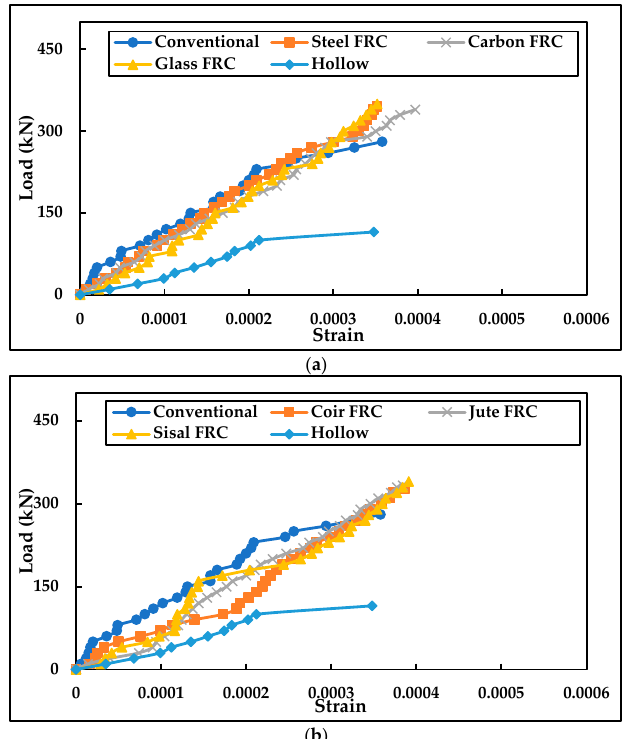
Figure 7. Graphical illustration of load vs. strain of medium columns. ( a ) Artificial FRC. ( b ) Natu- ral